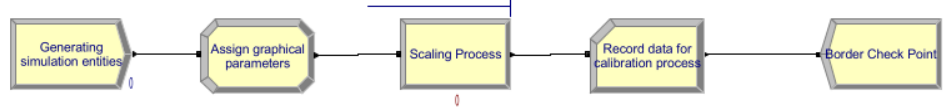
Figure 7. The simulation model for an actual situation.